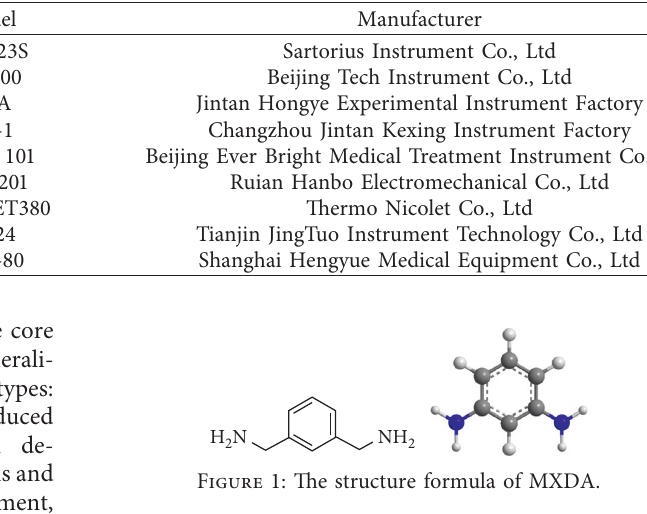
Table 1: Experimental instruments.